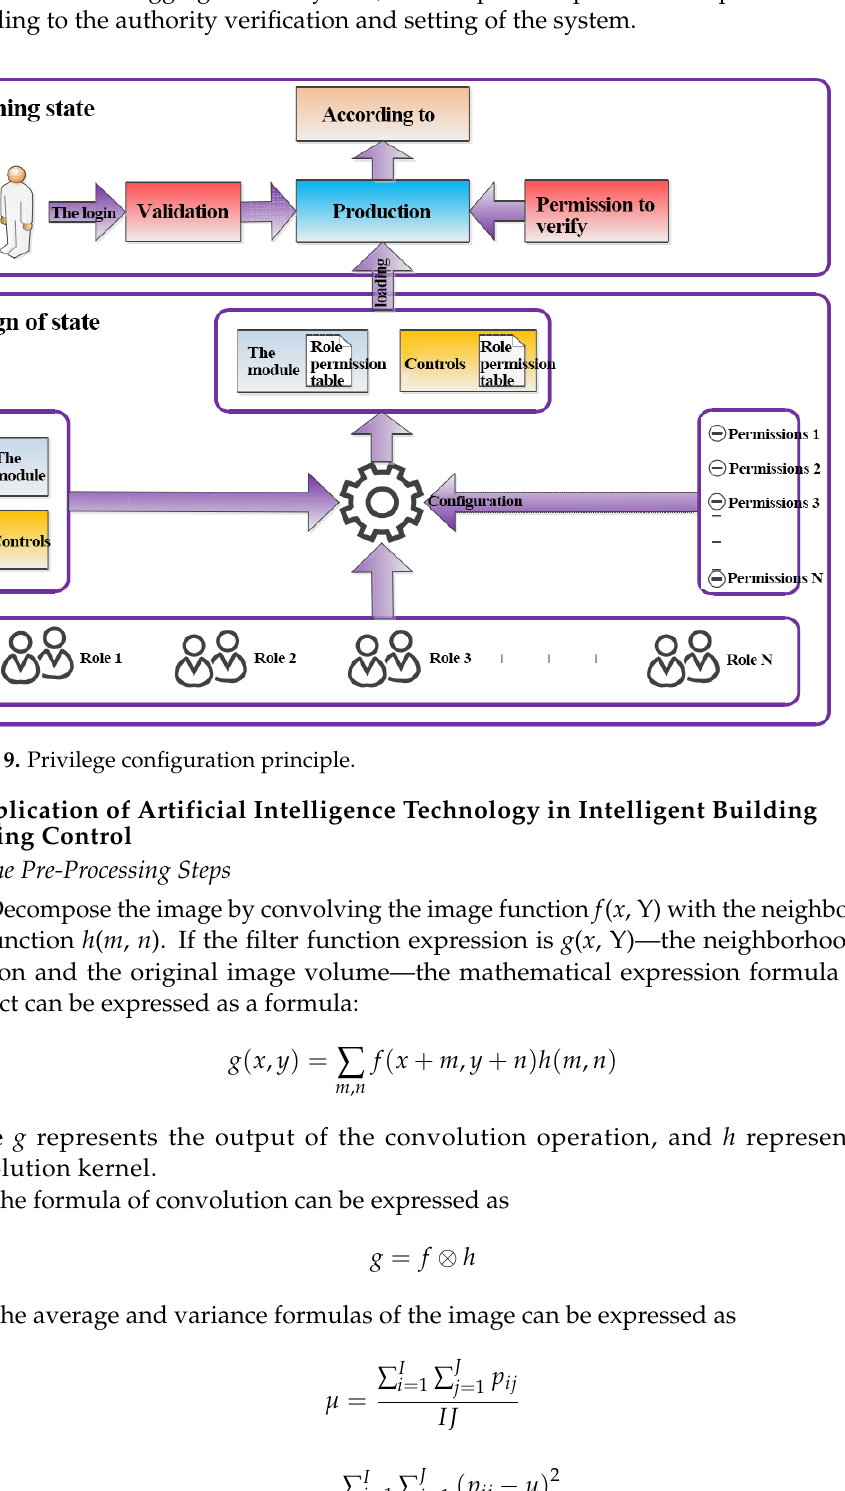
Figure 8. Schematic diagram of data acquisition configuration.